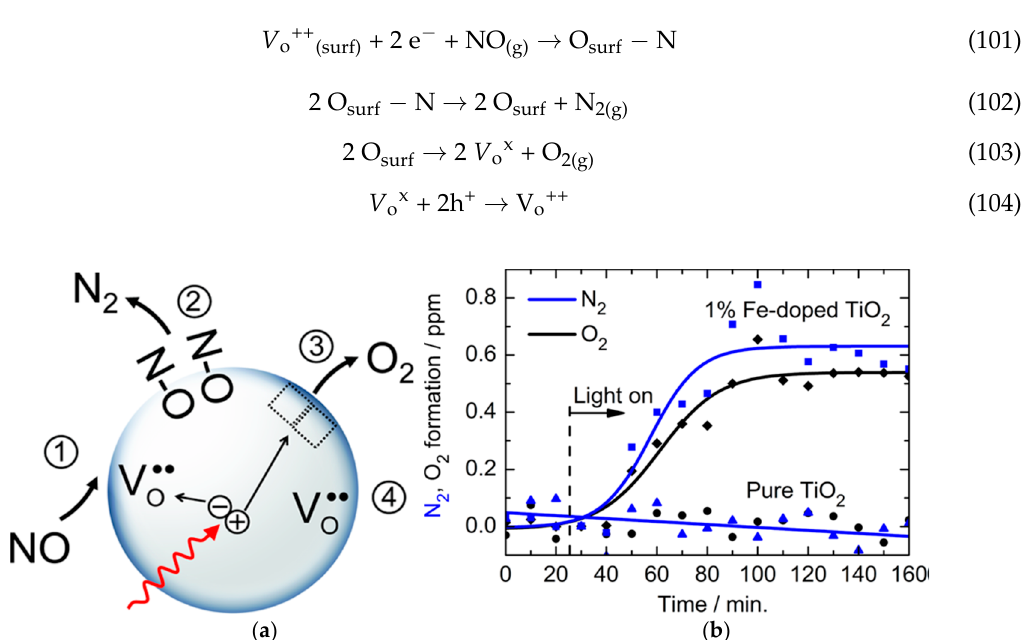
Figure 59. ( a ) Cartoon illustrating the possible pathway to reduce NO to N 2 and O 2 gases through the involvement of oxygen vacancies; and ( b ) photocatalytic conversion of NO to N 2 and O 2 over 1% Fe-doped TiO 2 under irradiation with UV light; concentration of NO: 100 ppm in He. Reproduced with permission from Ref. [176]. Copyright 2012 by the American Chemical Society.